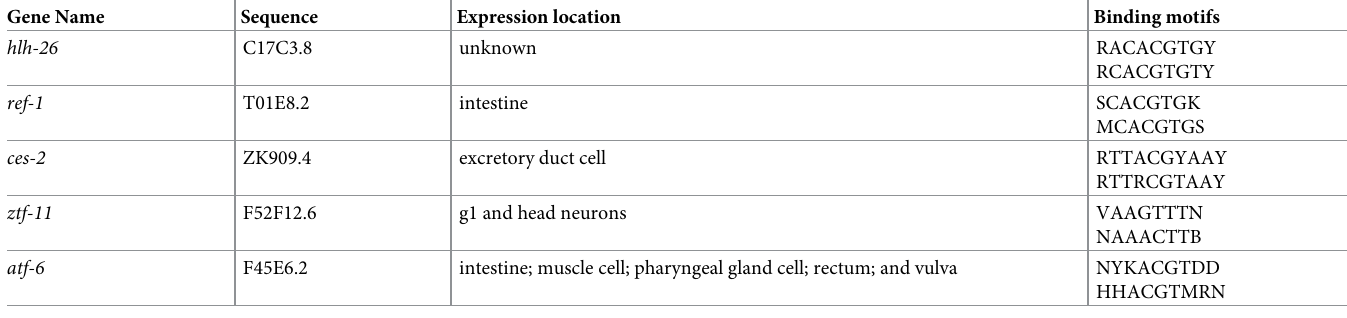
Table 1. Top-ranked candidate